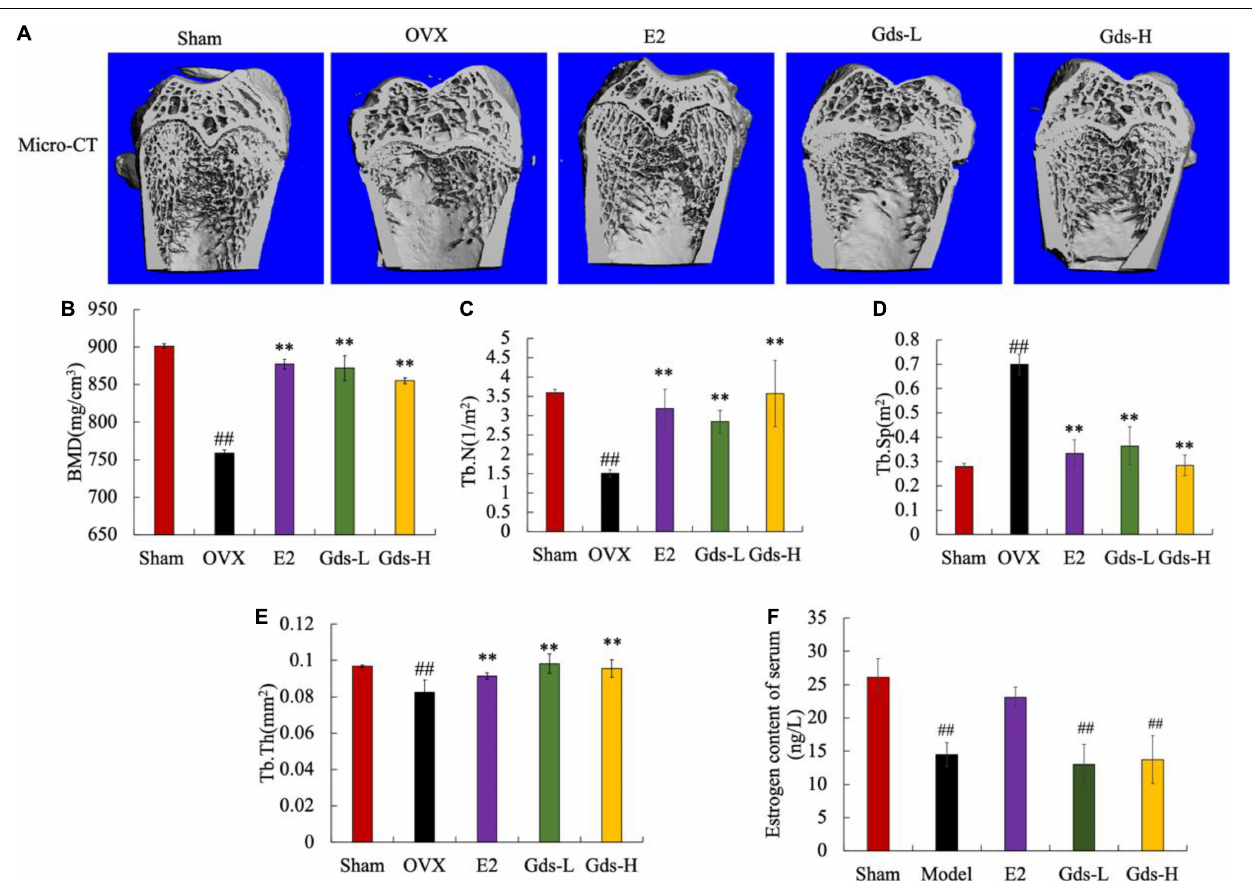
FIGURE 1 | Gds protected rats against the bone loss caused by estrogen deficiency. (A) Representative micro-CT image of trabecular region of each group; (B) BMD (mg/cm 3 ), bone mineral density; (C) Tb.N (1/m 2 ), trabecular thickness; (D) Tb.Sp (m 2 ), trabecular separation; (E) Tb.Th (mg/cm 2 ), trabecular thickness; (F) estrogen (ng/L). Sham, sham operated group; OVX, ovariectomized control group; Gds-L, low dose of Gadus morhua sialoglycoprotein-treated group; Gds-H, high dose of Gadus morhua sialoglycoprotein-treated group; E2, positive drug control group. Ave ± SE, # p < 0.05, ## p < 0.01 vs. Sham group; * p < 0.05, ∗∗ p < 0.01 vs. OVX group. n =